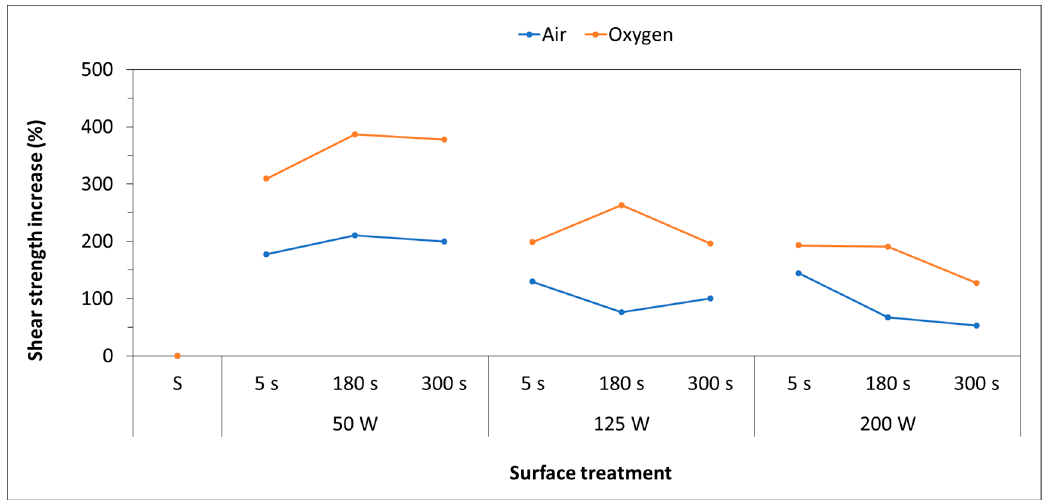
Figure 8. Shear strength increase of adhesive bonded joints as a function of LPP process parameters. Polymers 2019 , 11 FOR PEER REVIEW